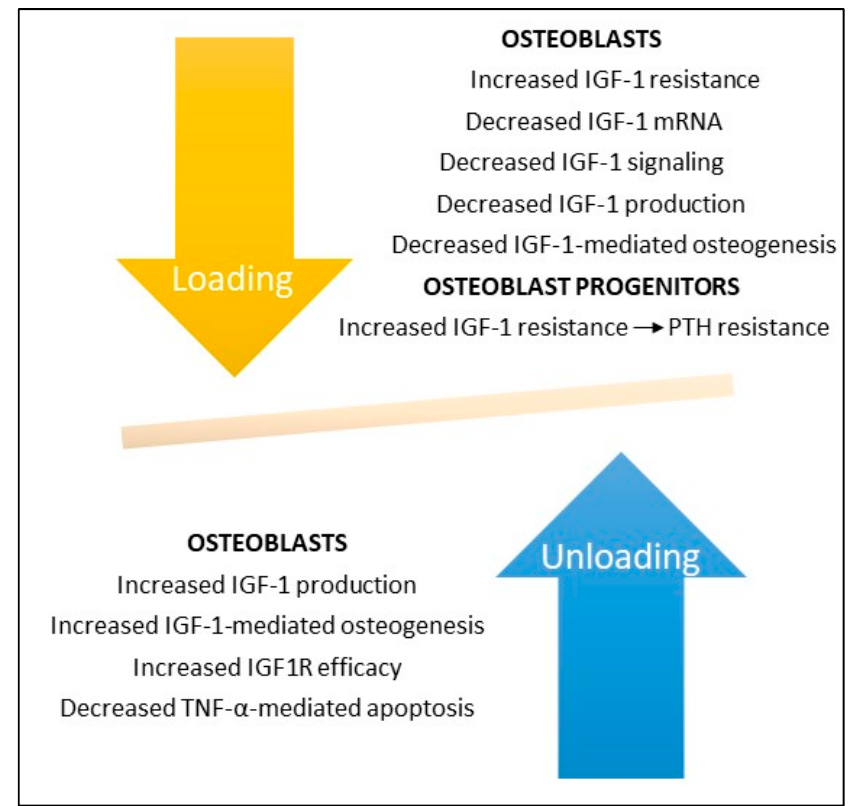
Figure 4. Bone loading and unloading experiments demonstrate the key role IGF-1 and its receptor IGF1R play in bone formation. Bone unloading increases IGF-1 resistance and decreases IGF-1 production, signaling, and IGF-1-mediated bone formation by osteoblasts and enhances IGF-1 and PTH resistance in osteoblast mesenchymal stem cell precursors. In contrast, bone loading increases IGF-1 production and IGF1R e ffi ciency and decreases TNF- α -mediated apoptosis in osteoblasts. Deletion of IGF-1 or IGF1R in rodents abrogates osteoblast responses to bone loading and unloading (not shown). Hind limb suspension in rats has been shown to inhibit IGF1R signaling pathways with consequent reduction in the number and di ff erentiation of osteoblast progenitors and reduced bone formation; responsiveness to IGF1R could be restored with reloading [54,55]. In contrast, unloading of